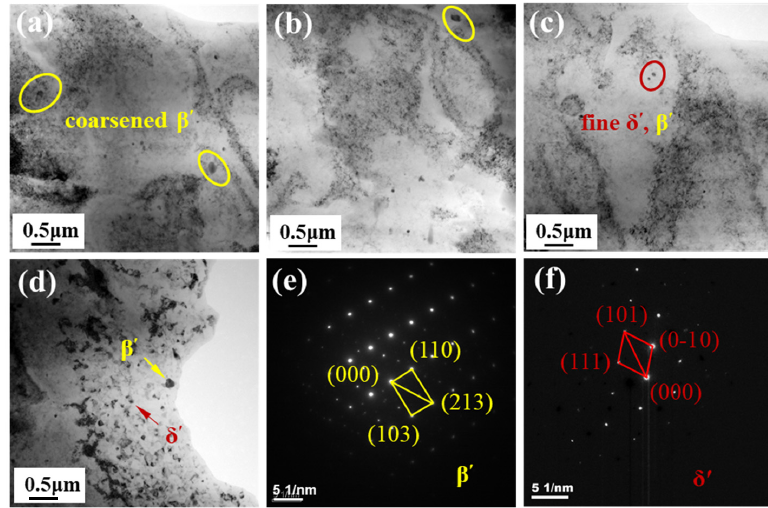
Figure 5. Distribution of reprecipitated phase particles in the NZ: ( a ) 90 mm/min; ( b ) 120 mm/min; ( c ) 150 mm/min; ( d ) 180 mm/min; ( e ) SAED of β ’ phase; ( f ) SAED of δ ’ phase.